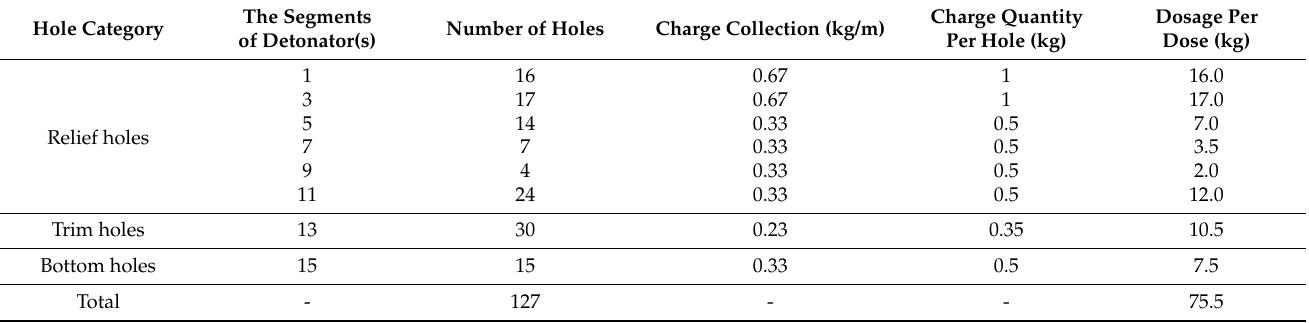
Table 2. The explosive charge for the left drift heading excavated by the CD excavation method.